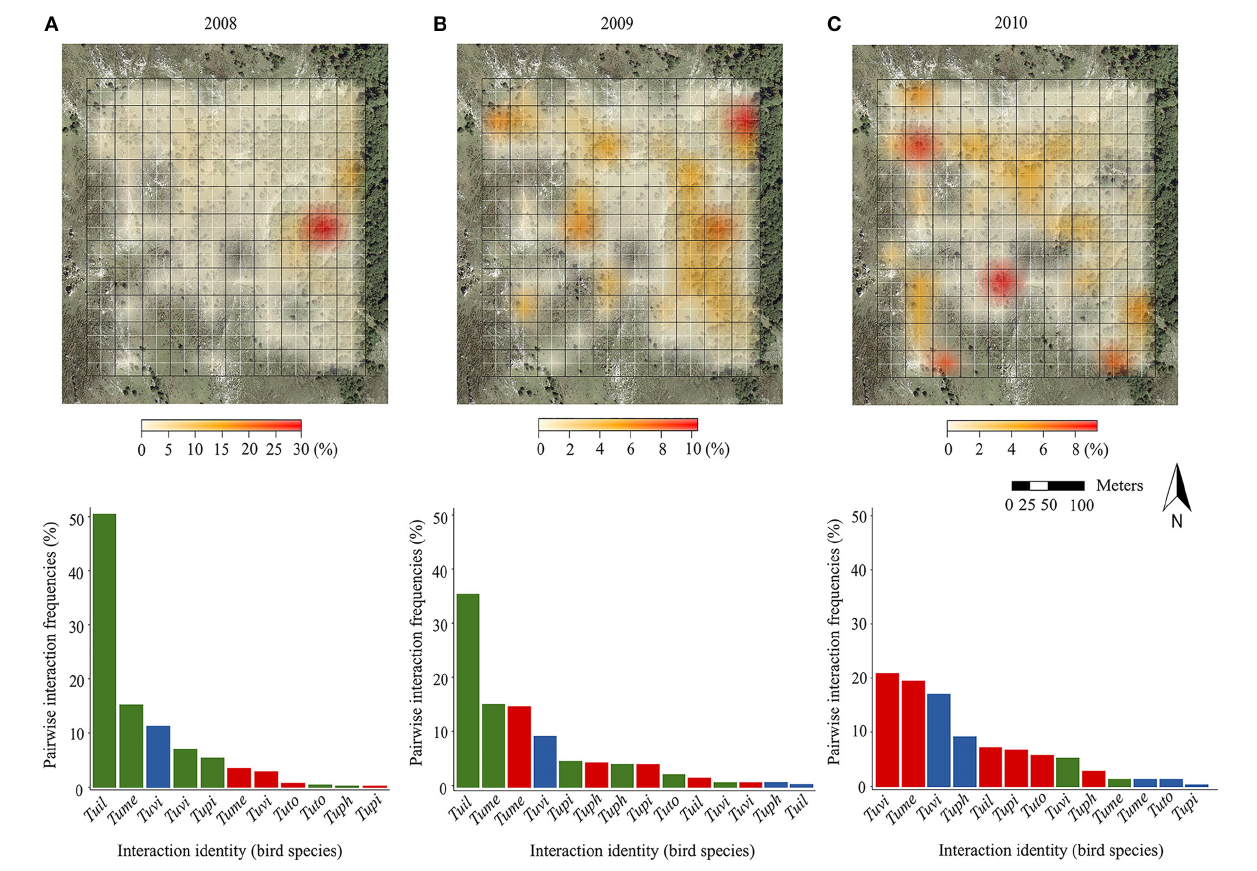
FIGURE 1 | In the upper panels, we show the spatial distribution of the sum of pairwise interaction frequencies accounted for by each of the 110 block (fruits consumed/10h of observation; expressed as a percentage scale) in the study plot (blocks depicted by black grid; original cells depicted by white grid) during three consecutive years: (A) 2008, (B) 2009, and (C) 2010. The color scales are shown below each panel, but note that the values change between years. Blocks without foreground color represent areas where no interaction could occur as there were no fruiting trees and/or birds recorded during that particular year. In the lower panels, we show the distribution of frequencies of pairwise interactions corresponding to different birds, in a decreasing order (bird species abbreviation codes in the y axis; Tuil, T. iliacus ; Tume, T. merula ; Tuph, T. philomelos ; Tupi, T. pilaris ; Tuto, T. torquatus ; Tuvi, T. viscivorus ) and tree species (green hues, I. aquifolium ; red, C. monogyna ; blue, T. baccata ) for different years in the study